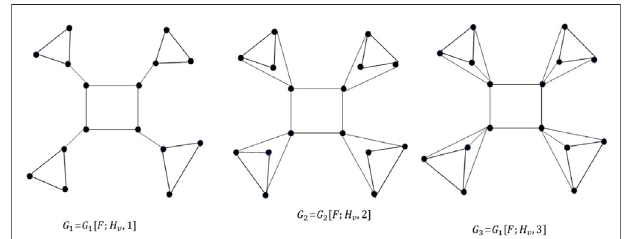
FIGURE 1 | [ F ; H v , l ] for different l .